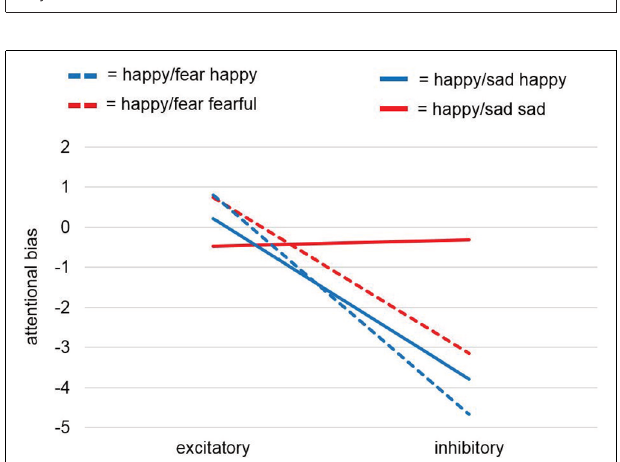
FIGURE 4 | Attentional bias analysis of the dot-probe task. Analyses of the attentional bias (for calculation see “Dot-Probe Task” section) for study samples Happy/Sad and Happy/Fear together revealed a significant main effect for factor Stimulation and thus pointed to a consistent effect for happy faces with excitatory vmPFC-tDCS compared to inhibitory vmPFC-tDCS leading to a relatively positive bias, i.e., a faster reaction to a dot after the presentation of a relevant cue (here, happy faces) at the same location. This was confirmed by a separate analysis for happy faces only yielding a significant difference between stimulations. For unpleasant faces only (sad, fearful) no differences were